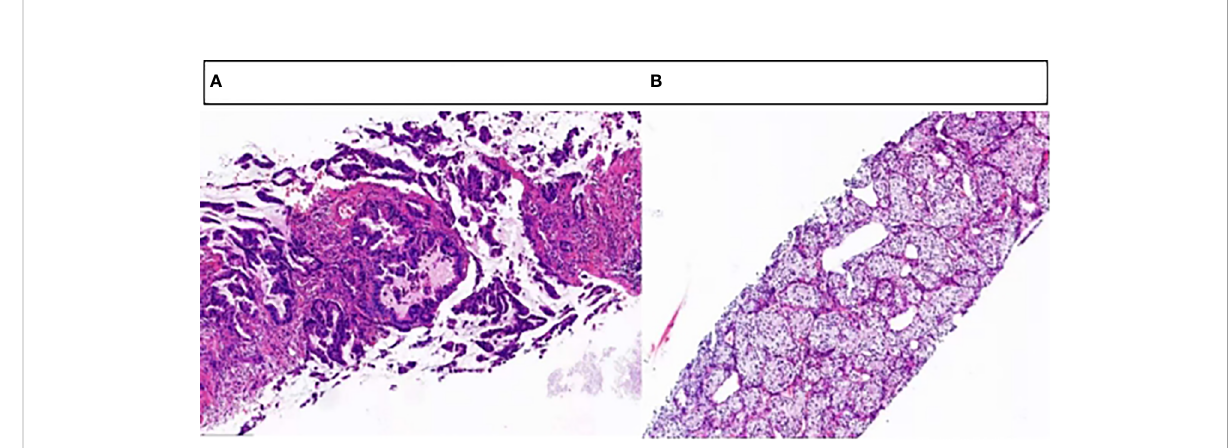
FIGURE 4 Tissue sections stained with hematoxylin-eosin. (A) Adenocarcinoma of the left lung. (B) Left renal clear cell